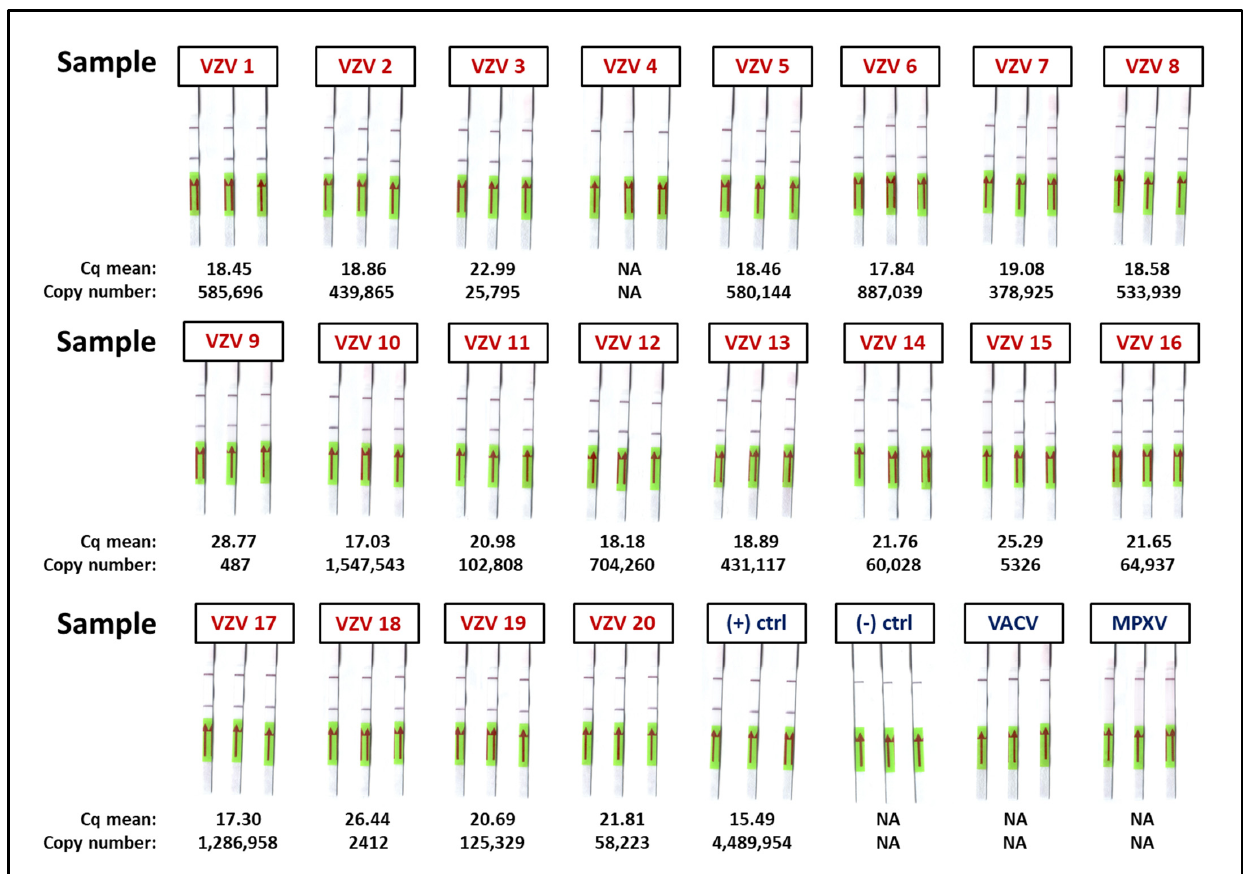
Figure 3. Detection of VZV in clinical samples. Twenty VZV samples were tested with qPCR, but one (sample 4) tested negative for VZV. The positive control used was the VZV plasmid with a concentration of about 3.62 × 10 6 copies/ μ L, and nuclease ‐ free water for the negative control. The specificity of RAA ‐ LF was determined using the DNA of monkeypox virus (MPXV) and vaccinia virus (VACV), and both viruses tested negative for VZV. RAA ‐ LF for VZV detection was also con ‐ ducted, in triplicate, using the same clinical samples tested with qPCR. Nineteen samples, along with the positive control, tested positive for VZV by RAA ‐ LF with the presence of the test band on the dipstick, while sample 4 only exhibited the control band, conforming to the results of the qPCR.